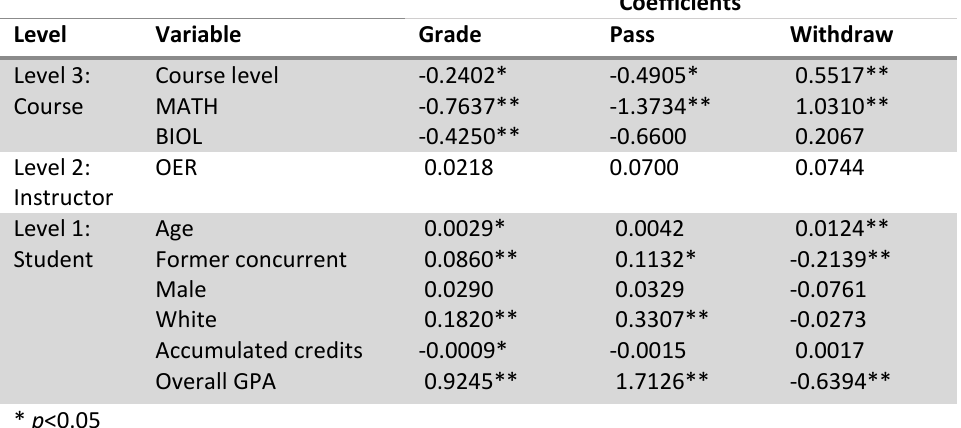
Figure 9. Results – Continuing